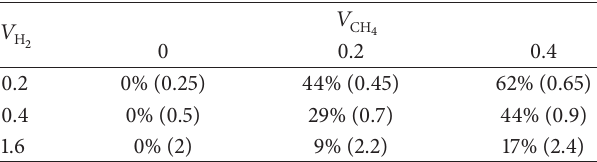
Table 1: The percentage of methane content in influent gas and ) for Experiment 3. Three different total influent flow rate ( 𝑉 in ) were evaluated for three different methane influent rates ( 𝑉 CH 4 ) while maintaining the stoichiometric hydrogen influent rates ( 𝑉 H 2 :CO gas mixture ratio. The total influent flow rate ( 𝑉 4:1 H 2 2 shown in brackets in